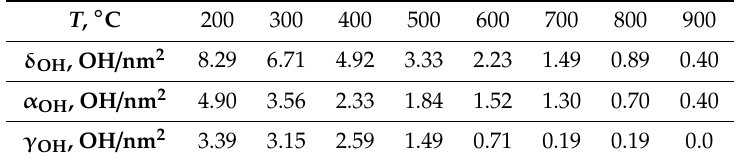
Table 7. Distribution of OH-groups between surface and volume for hydrothermal silica